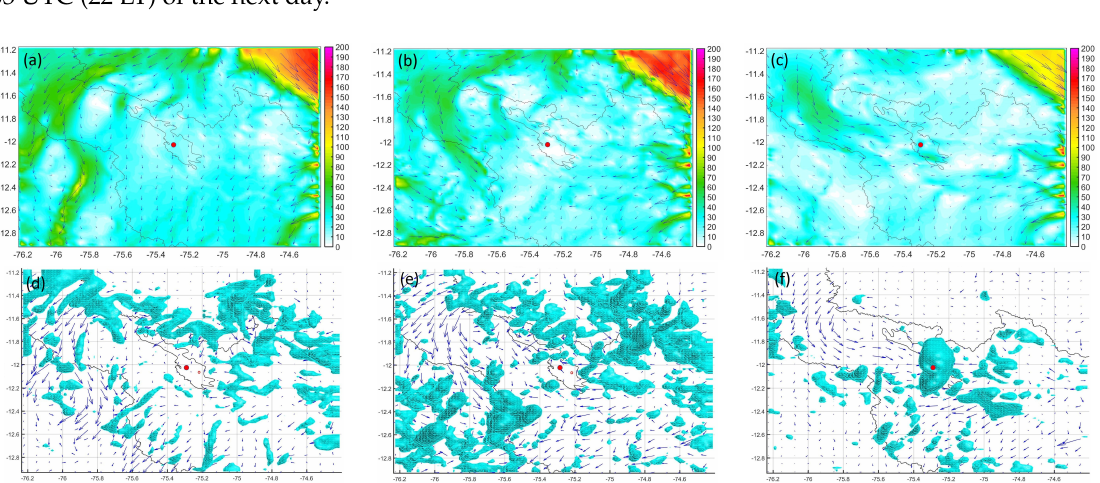
Figure 9. Horizontal flow of vertically integrated total column of water vapor flux (kg m − 1 s − 1 ) around the Mantaro basin at ( a ) 15 UTC (10 LT); ( b ) 18 UTC (13 LT) and ( c ) 01 UTC (20 LT). Horizontal flow of surface wind (m s − 1 ) with combined issosurface of cloud, ice, rain and hail mixing ratios ( q c + q i + q c + q h + q s ) (0.5 g kg − 1 ) over the Mantaro basin at ( d ) 15 UTC (10 LT); ( e ) 18 UTC (13 LT) and ( f ) 01 UTC (20 LT). All fields were obtained from the WRF model (resolution: 2 km) for the convective event TS1. The full red circle indicates the location of the Huancayo